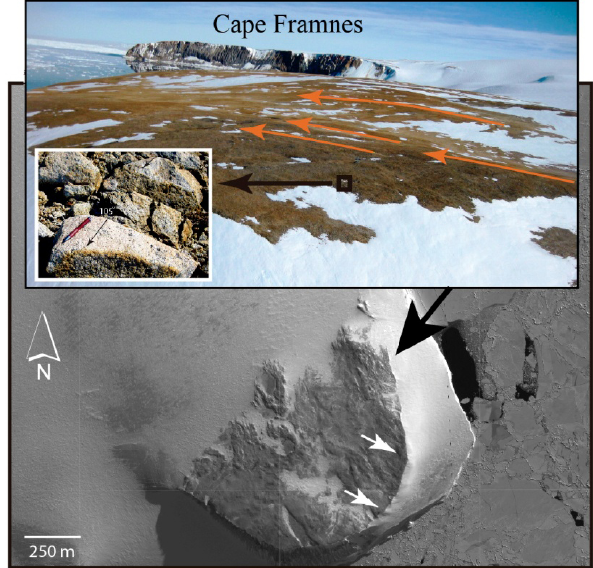
Figure 4. Photograph from Cape Framnes showing bedrock stria- tions and flute orientations ESE in agreement with the southward flow orientation observed on the seafloor (this study). The location of the photograph and its aspect are indicated by the black arrow on the Landsat Scenes LIMA. The insets show an isolated bedrock rib, its location on the landscape, and the flow direction of striations and bedrock flutes (orange and white arrows) in each case (figure mod- ified from a map compiled by Spences Niebuhr, Polar Geospatial